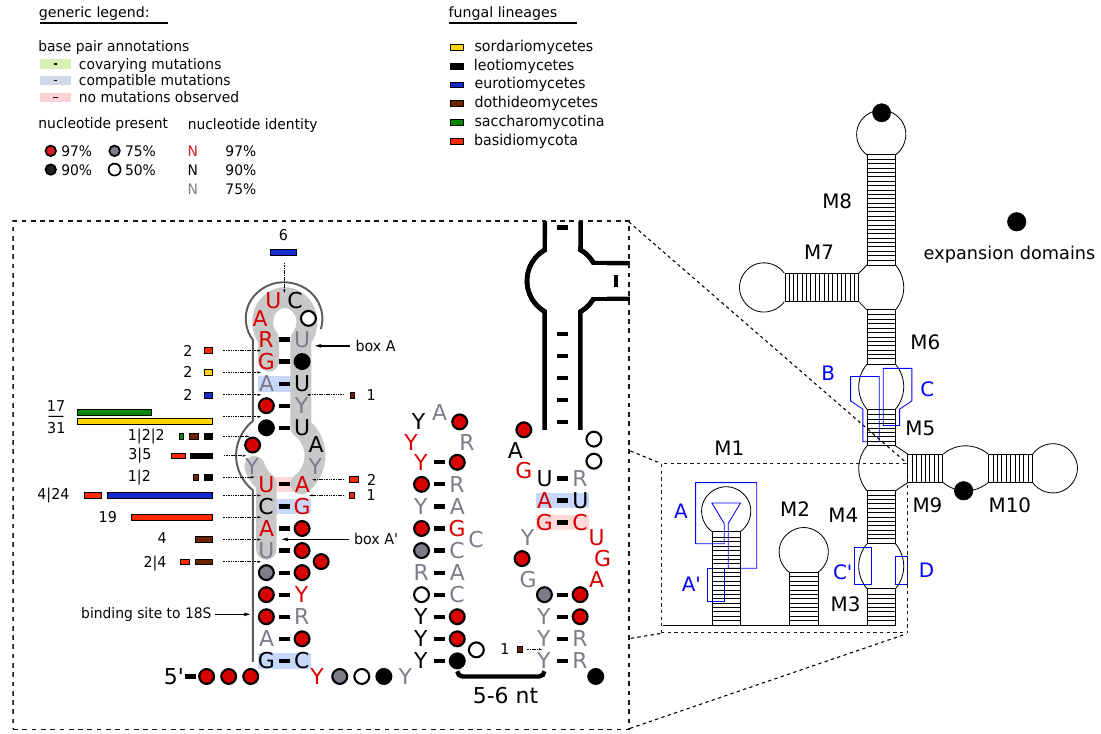
Figure 1. Overview map of U3 snoRNAs. The schematic overview on the left (redrawn from Marz and Stadler [3]) defines the nomenclature of the 10 stem and hairpin regions, and indicates the location of the conserved box motifs. The detail on the right, summarizes the particular features of fungal U3 snoRNAs, including the more complex structure of M1. It also indicates the insertion points of introns, which are predominantly located within the 5’ arm of the stem-loop structure M1. The lengths of the bars and the corresponding numbers give the number of species with introns at a particular location, the color indicates their membership in one of the major clade. The drawing was constructed using R2R